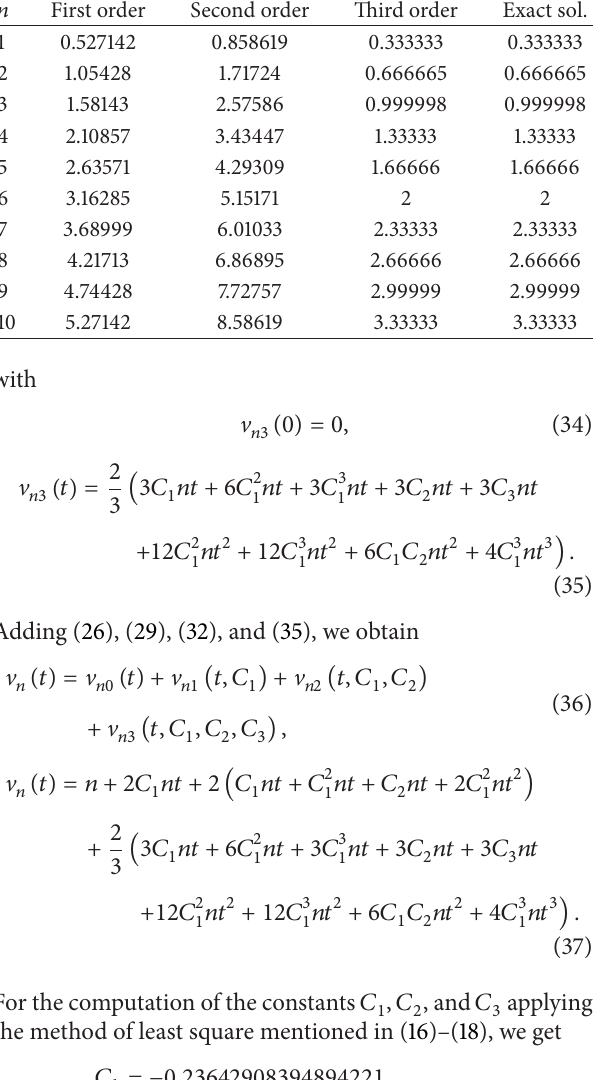
Figure1:ComparisonofOHAM,exact,andADMsolutionsat 𝑡 = 1 .